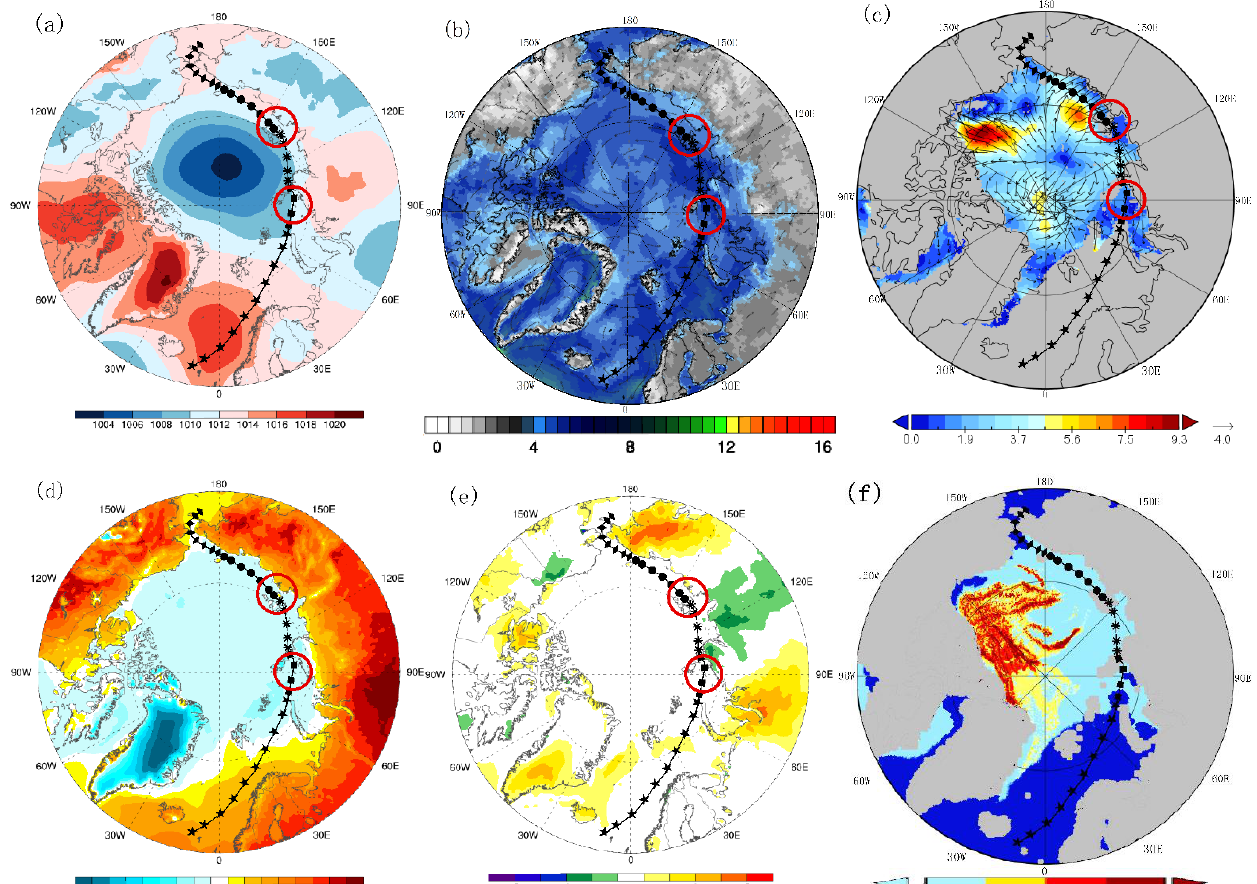
Figure 12. Distribution map of ( a ) sea level pressure (unit: hpa); ( b ) wind field (unit: m −1 ); ( c ) sea ice movement (unit: m −1 ); ( d ) temperature (unit: centigrade); ( e ) temperature anomaly (unit: centigrade) and ( f ) sea ice age (unit: year) in the Arctic summer in June 2016. (The red circles represent the special areas.)